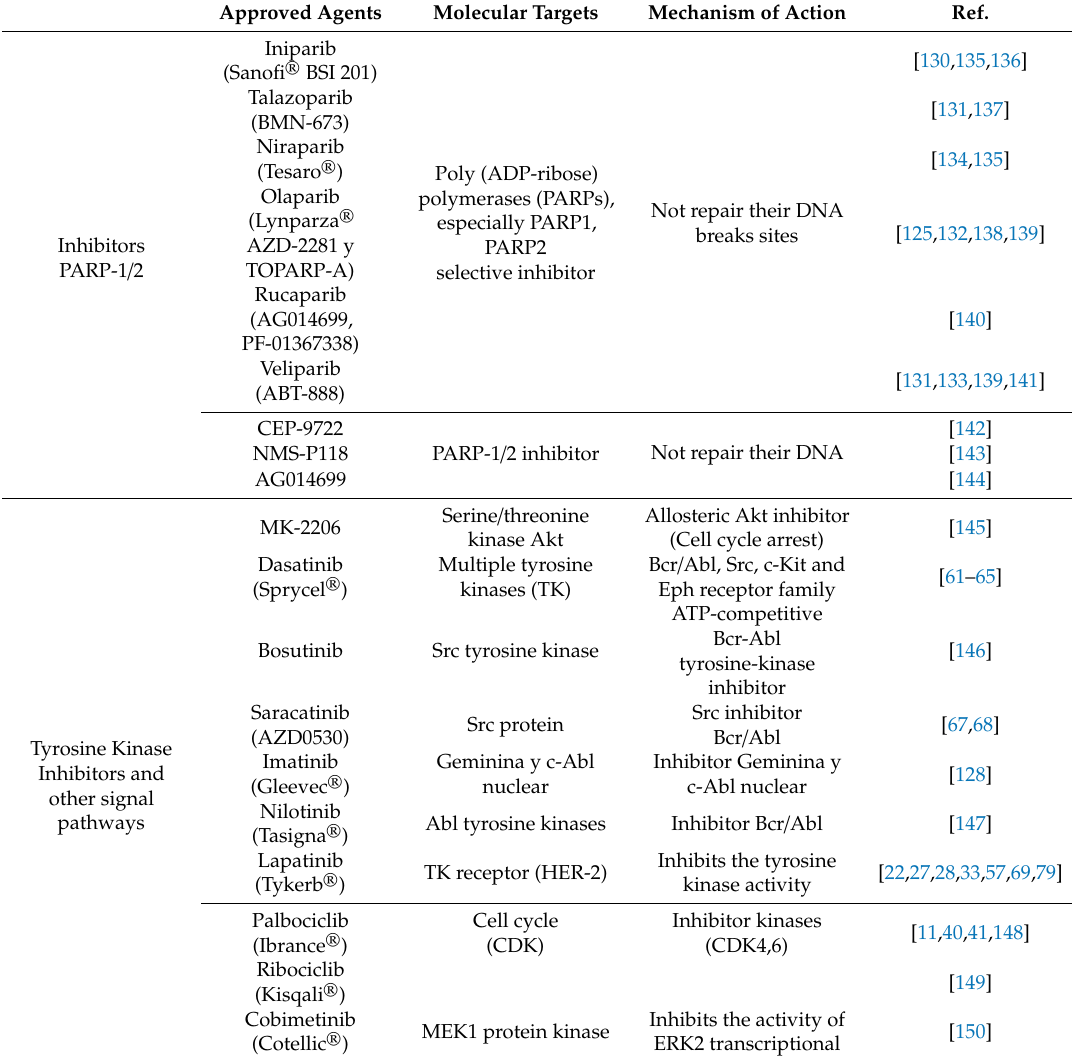
Table 3. Poly [ADP-ribose] polymerase (PARP)-1 / 2 inhibitors and other signal pathways inhibitors in breast cancer